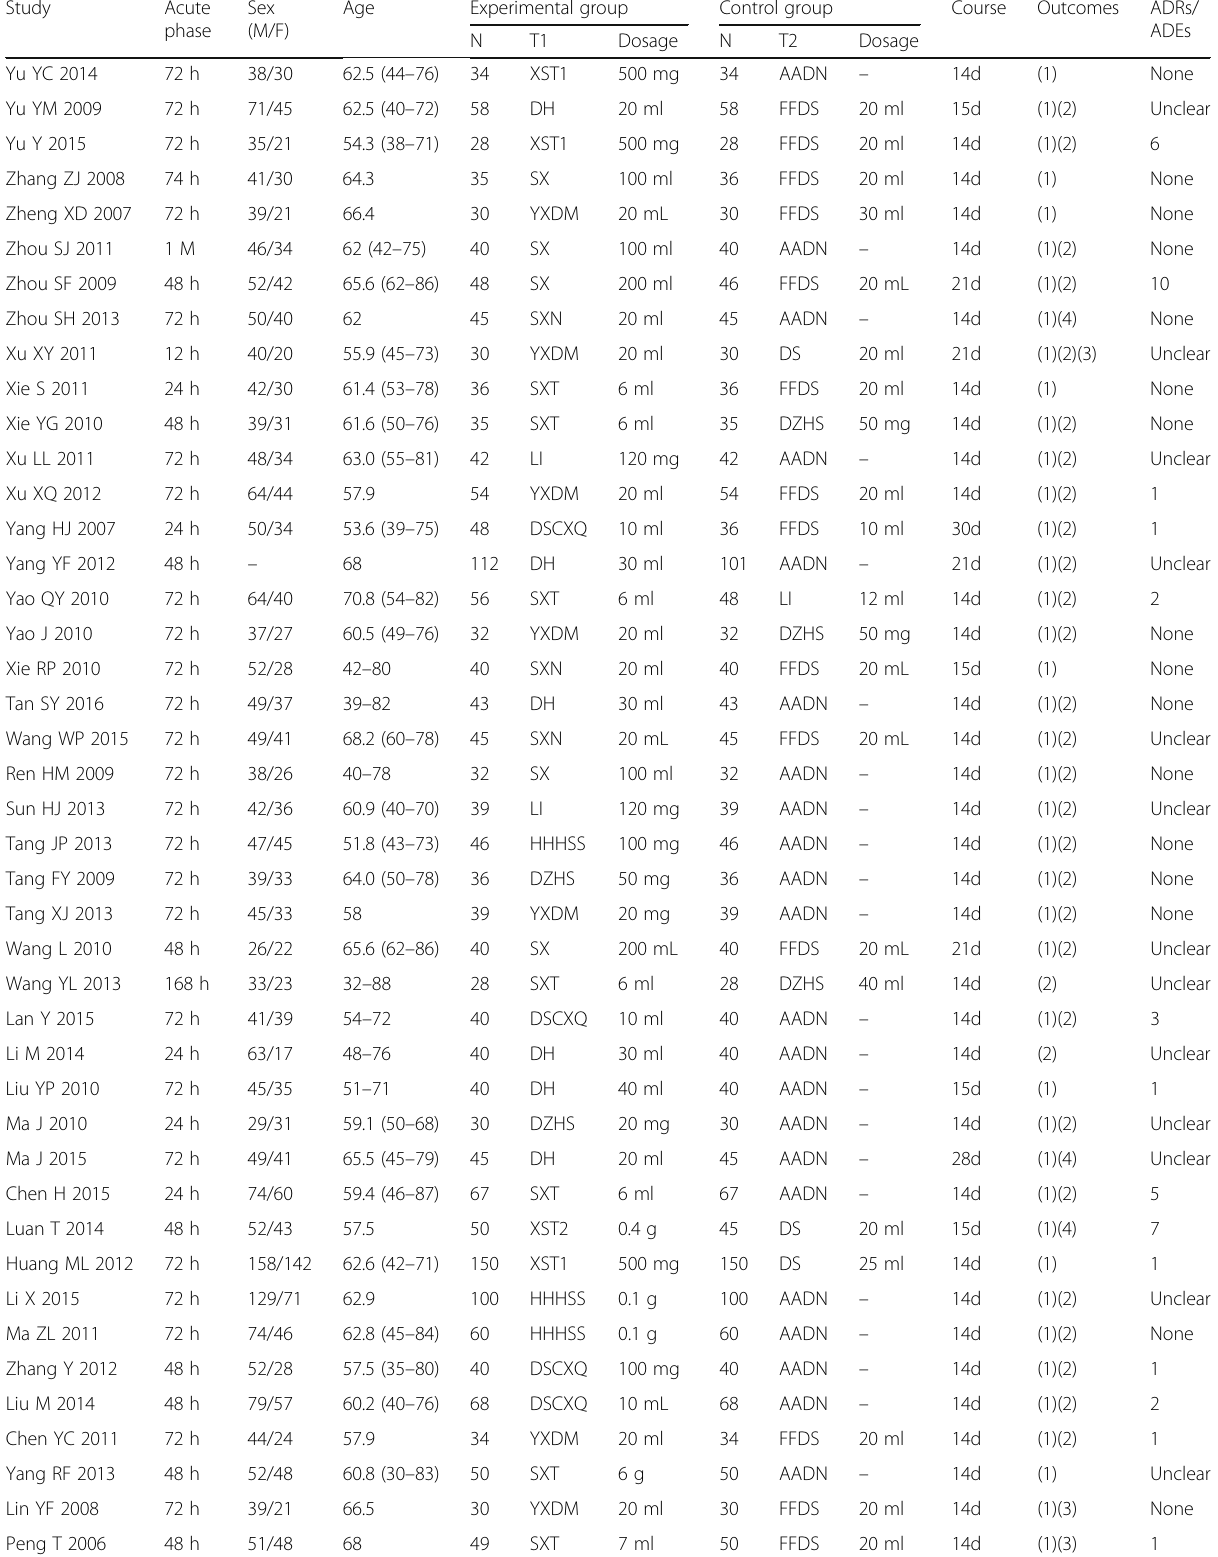
Table 2 Characteristics of the studies included in this